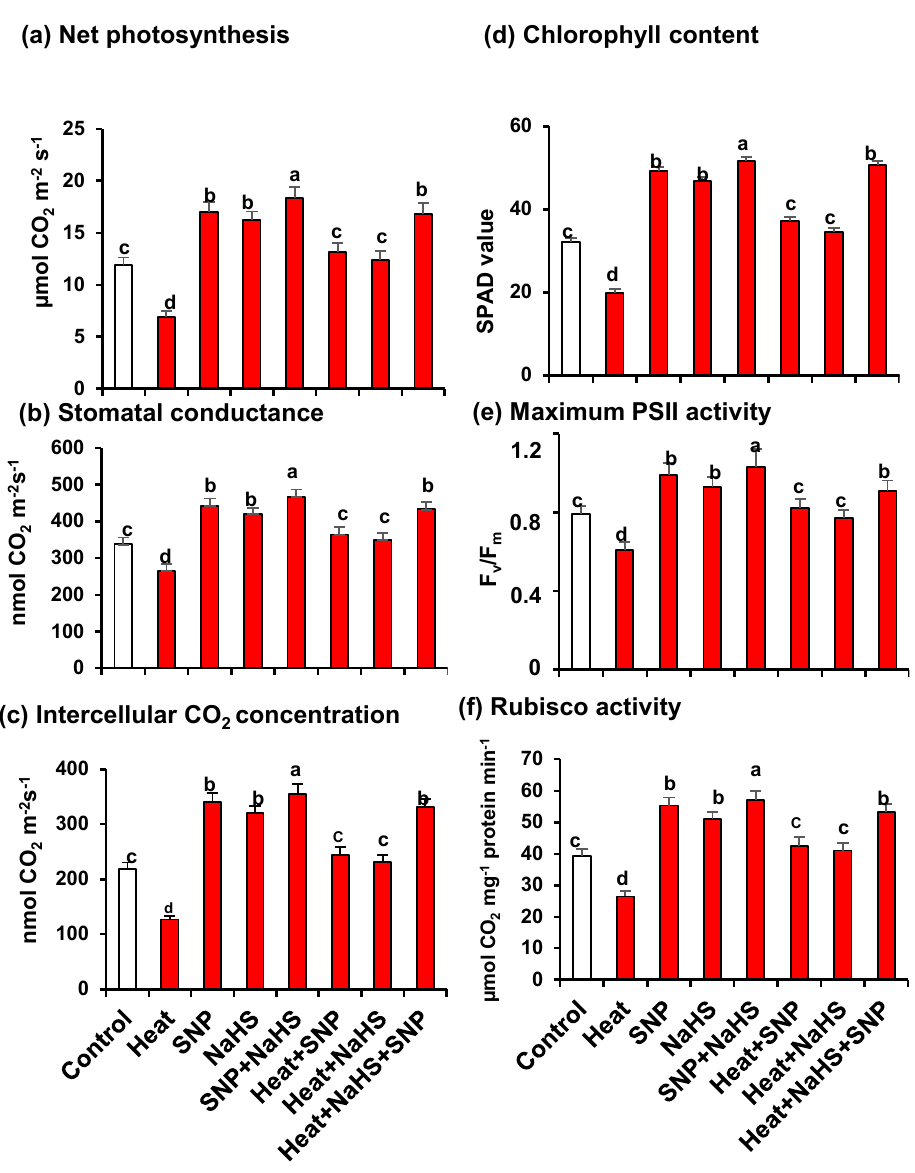
Figure 2. ( a ) Net photosynthesis. ( b ) Stomatal conductance. ( c ) Intercellular CO 2 concentration. ( d ) Chlorophyll content. ( e ) Maximum PSII activity. ( f ) Rubisco activity in wheat ( Triticum aestivum L. var. WH 542) leaves treated with SNP (100 µM) and/or NaHS (200 µM) in the presence (40 °C) or absence (25 °C) of heat stress at 30 days after sowing (DAS). Data are presented as treatments mean ± SE ( n = 4). Data followed by the same letter are not significantly different by LSD test at ( p < 0.05). SNP, sodium nitroprusside; NaHS, sodium hydrosulfide.